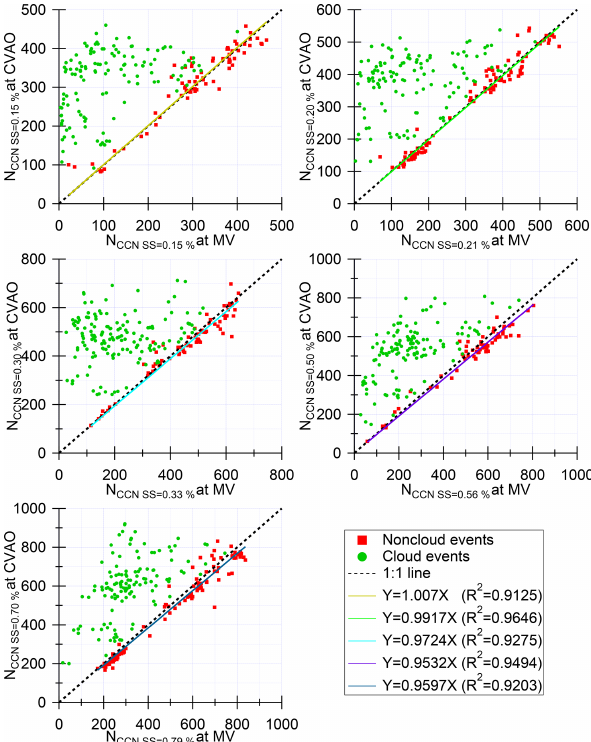
Figure 9. Scatter plots of N CCN at CVAO against those at MV at different supersaturations. Slope and R 2 values for these fits are given in the